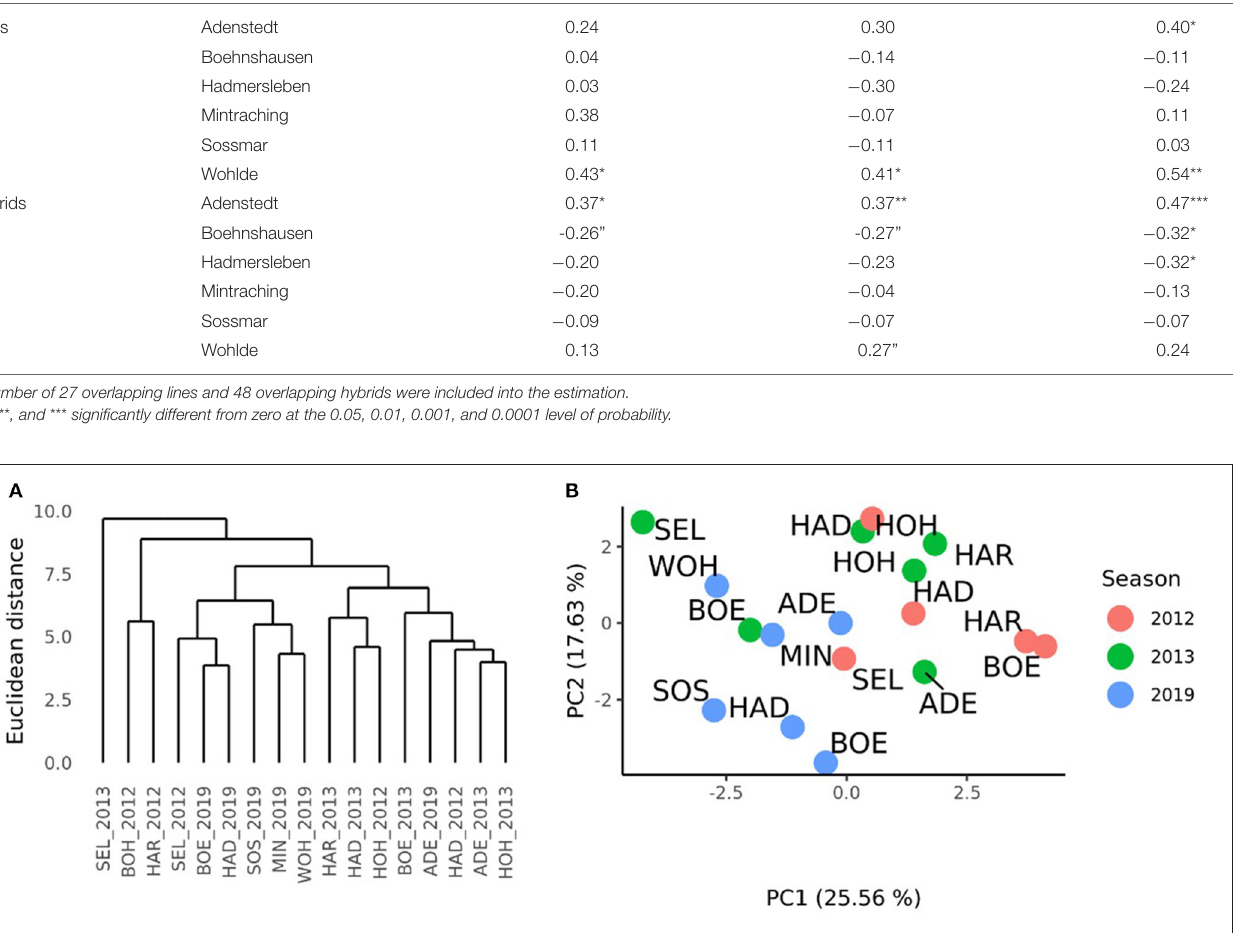
FIGURE 4 | Characterization of the environments of the HYWHEAT and RRGS experiments of the growing seasons 2011/2012, 2012/2013, and 2018/2019, based on the phenotypic performances of overlapping tested hybrids. (A) Dendrogram based on the Euclidean distances among 17 location times year combinations (location_year) estimated using the GCA Female -by-environment interaction effects from the grain yield trials performed in the year 2012 and 2013 for the training population (HYWHEAT) and in the year 2019 to assess the selection gain of the reciprocal recurrent genomic selection program. (B) PCA based on the GCA Female -by-environment interaction effects of 16 location times year combinations. The locations were indicated as ADE, Adenstedt; BOE, Boehnshausen; HAD, Hadmersleben; HA R, Harzhof; HOH, Hohenheim; MIN, Mintraching; SEL, Seligenstadt; SOS, Sossmar; WOH,